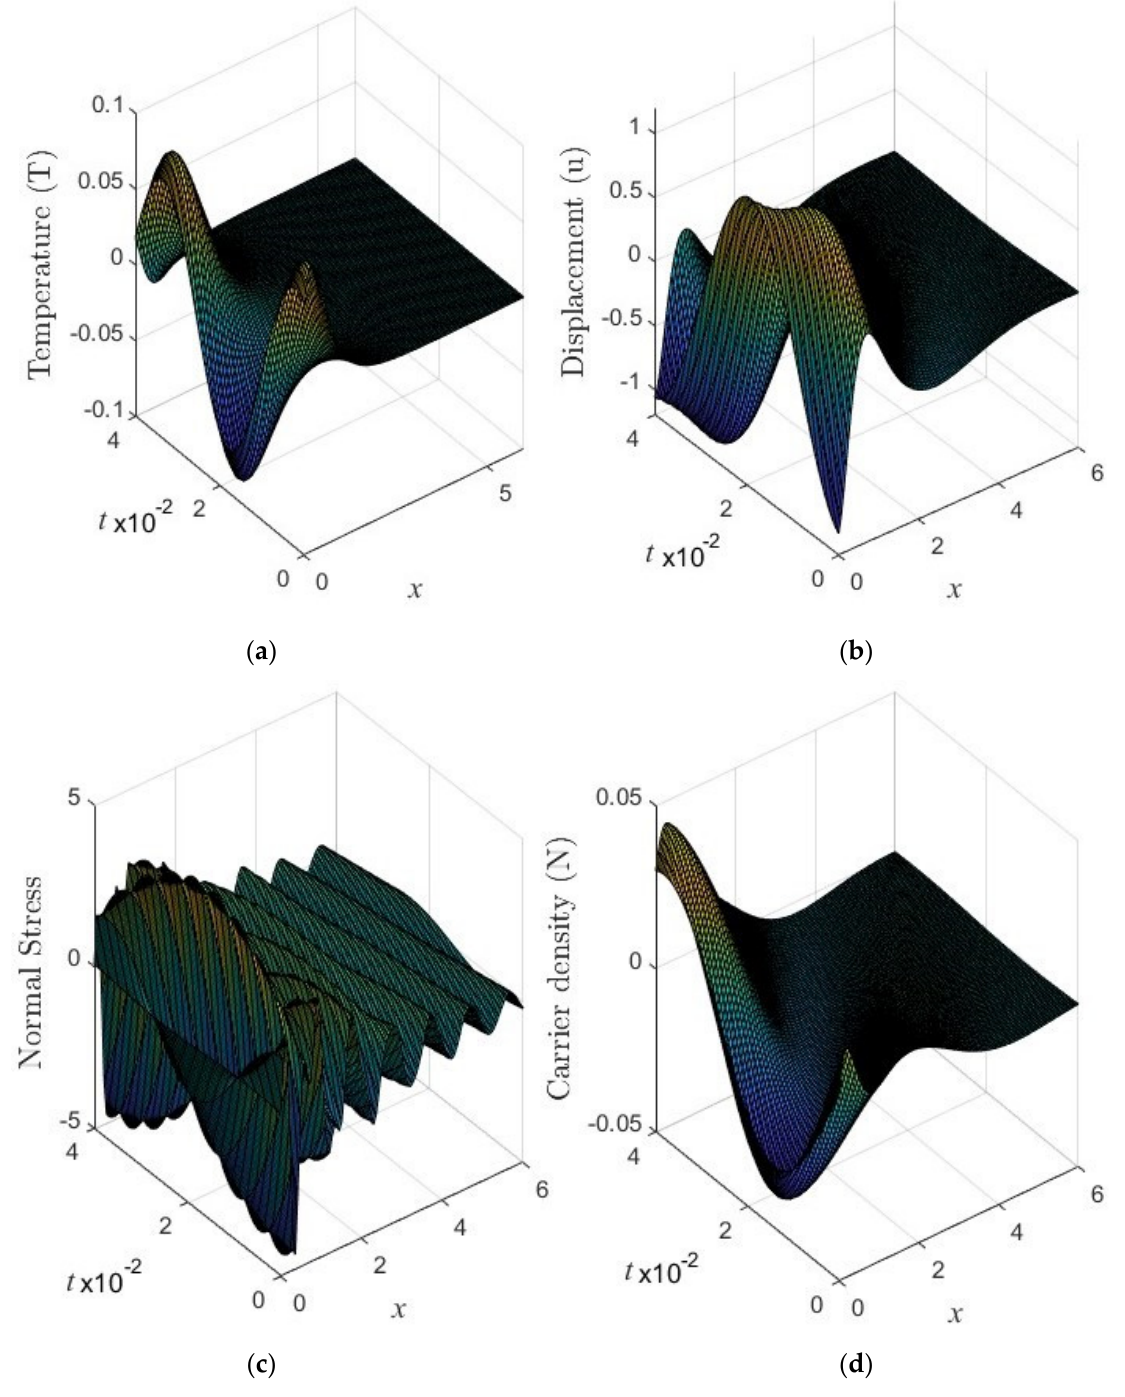
Figure 5. ( a – d ) The wave propagation of the physical field distributions against the distance and time interval [0, 0.04] according to Si materials in the context of the DPL model.